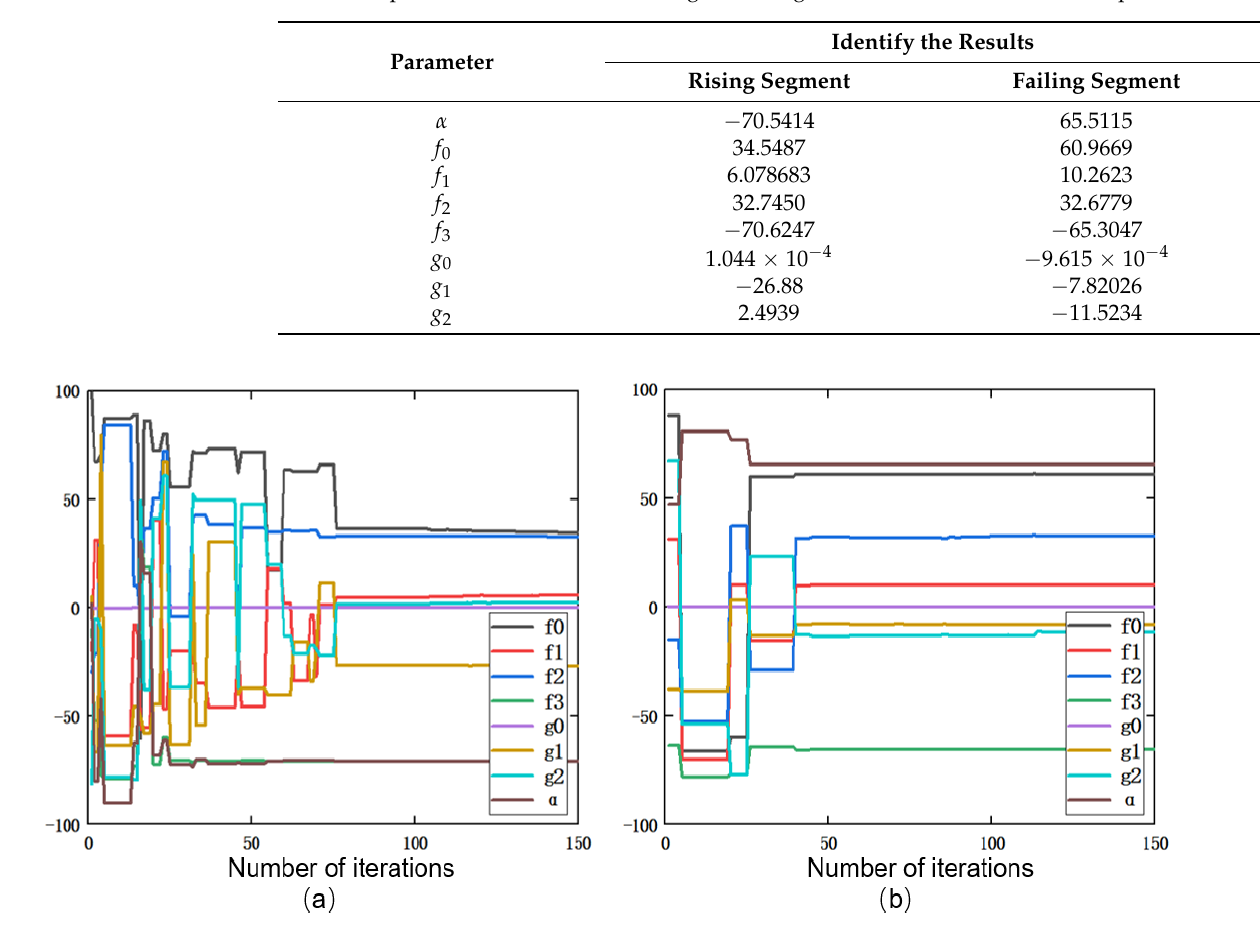
Figure 7. Improved parameter convergence process of artificial fish swarm algorithm model: ( a ) ascending segment; ( b ) descending segment.